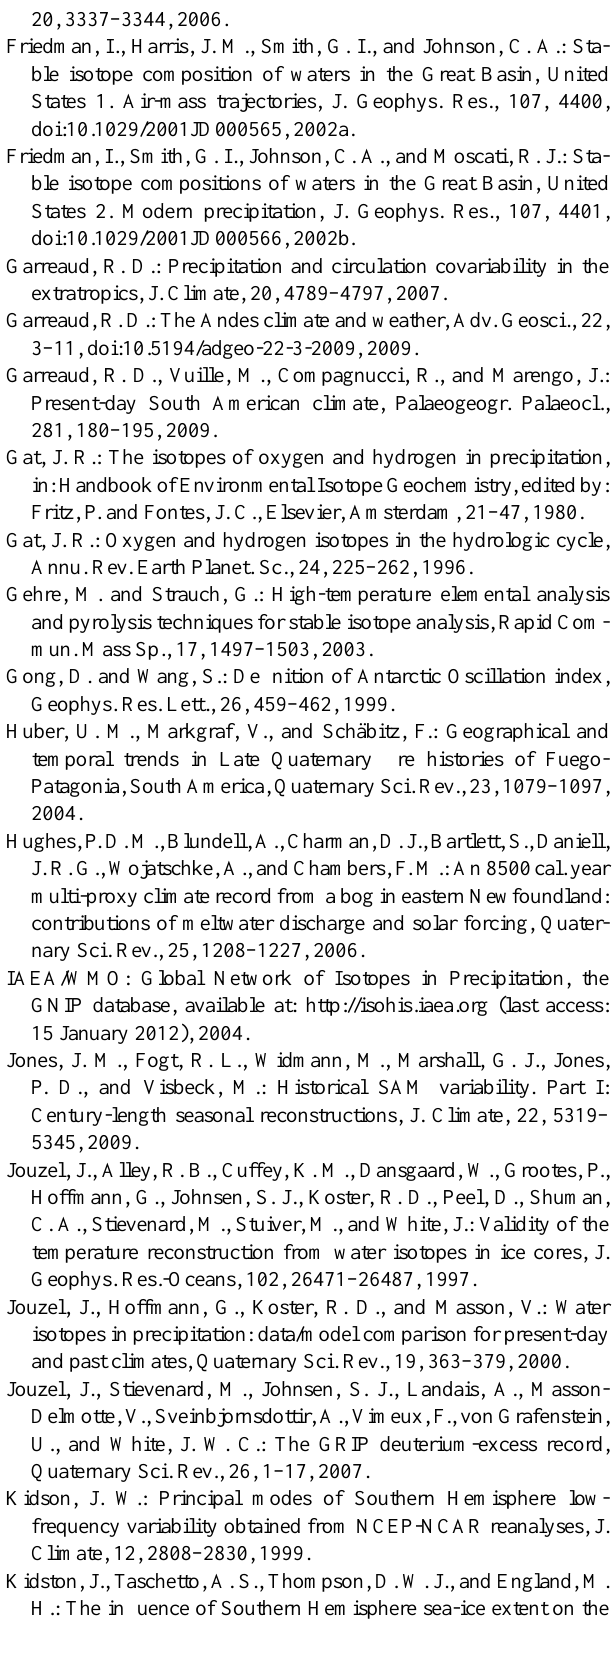
table reconstructions from northern Britain, Quaternary